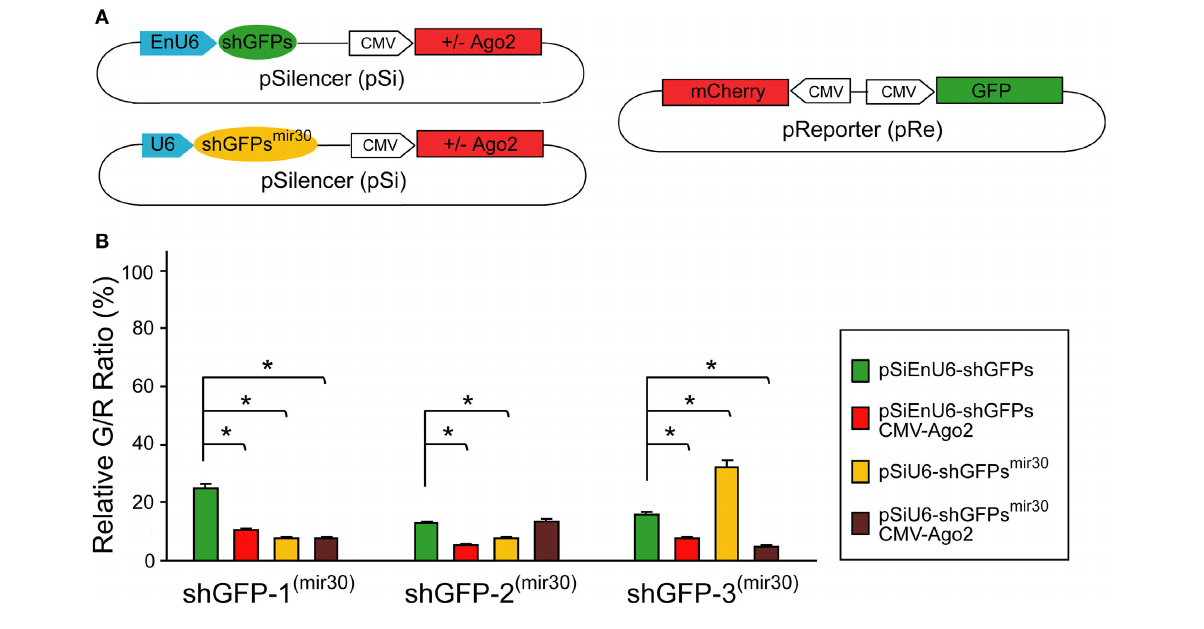
For shGFPs, Ago2 co-expression broadly enhances GFP knockdown (red bars). For shGFPs mir30 , the RNAi effi ciency increases for shGFP-1 mir30 and shGFP-2 mir30 but not shGFP-3 mir30 (yellow bars). Additionally, Ago2 co-expression enhances knockdown with all shGFPs mir30 to a level comparable to Ago2 co-expression with shGFPs. Asterisks represent statistical signifi cance ( p < 0.05, ANOVA-Scheffe’s